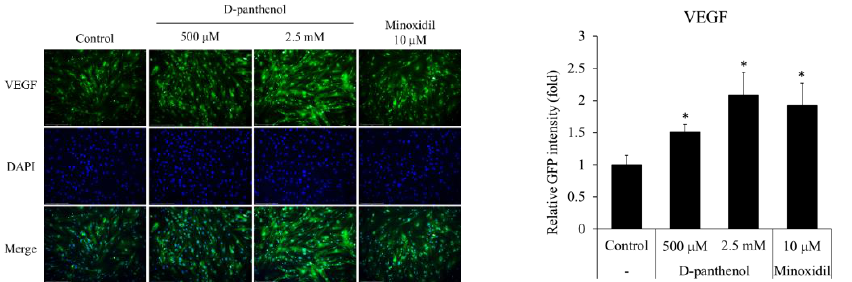
Figure 5. D-panthenol stimulated VEGF expression in cultured hDPCs. The protein level of VEGF in cultured hDPCs was evaluated by immunocytochemistry after 24 h treatment of D-panthenol (×200 magnification). * p < 0.05, ** p < 0.01 versus control group. Data are expressed as mean ± SD.